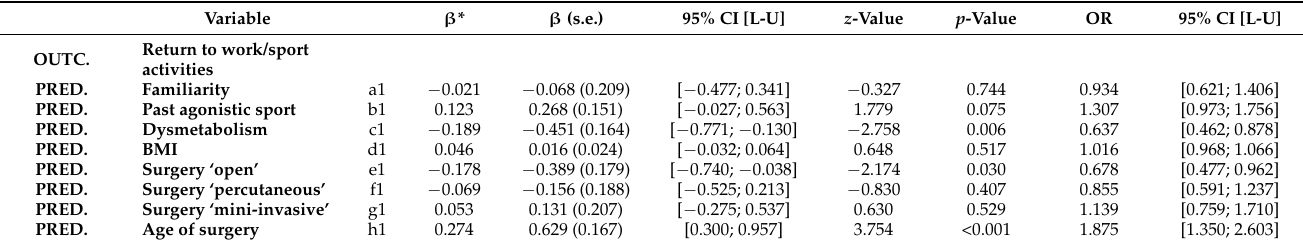
Table 4. Multiple multivariate logistic regression. Note: OUTC. = outcome variable; PRED. = predictor variable; β * = standardized beta coefficient; β = unstandardized beta coefficient; s.e. = standard